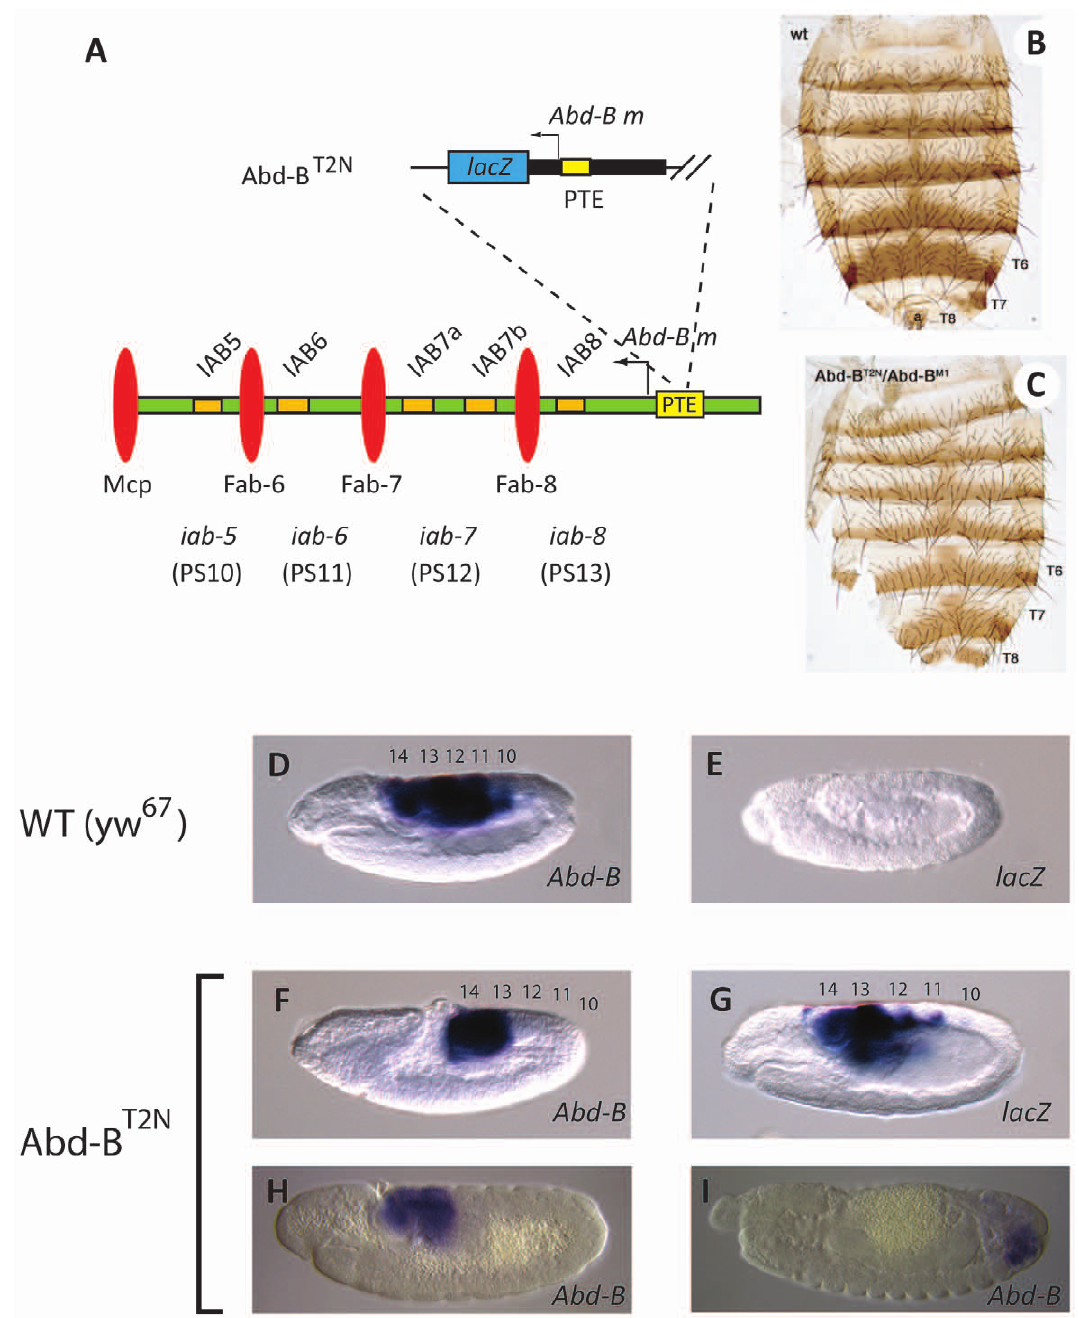
Figure 2. P element insertion into the endogenous PTE results in homeotic transformation and loss of Abd-B expression. ( A ) Schematic diagram of the Abd-B T2N P element line, showing the insertion site 2 241 bp 5 9 of the Abd-B m transcription start site in the endogenous PTE sequence. The same symbols and color scheme as in Fig. 1 indicate the neighboring cis -regulatory modules. ( B ) Dorsal cuticles were prepared from adult females. A normal abdominal pigmentation pattern is observed in wild-type (WT) adults. ( C ) In Abd-B T2N / Abd-B M1 hemizygotes the seventh abdominal tergite (T7) is fully developed, indicating a transformation toward a more anterior abdominal segment identity. The eighth abdominal tergite (T8) also shows a partial transformation toward a more anterior identity. Abd-B M1 is a Class III null allele for both the Abd-B m and r transcripts [15,27]. Abd-B gene expression pattern in wild-type (WT) ( D ) and Abd-B T2N ( F ) germ-band elongation stage 9 embryos. The staining patterns for the Abd-B T2N line show reduced Abd-B expression in parasegments (PS) 10, 11 and 12 at stage 9 ( F ), stage 11 ( H ) and stage 13 ( I ) of development. The lacZ reporter gene is expressed in developing posterior regions of the Abd-B T2N embryos ( G ). Expression is strongest in PS13, although the pattern extends from PS 10–14 and is very similar to the endogenous Abd-B transcription pattern. No lacZ expression is detectable in WT embryos ( E ).